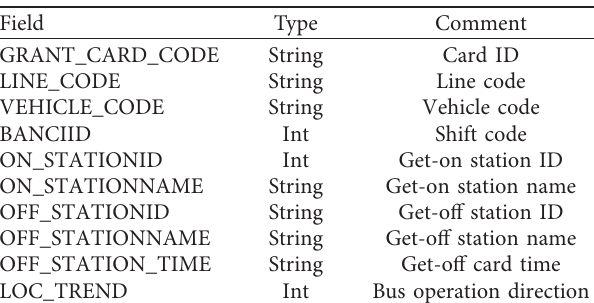
Figure 2: Bus line (sourcing from Amap: https://ditu.amap.com/). Table 2: Data field